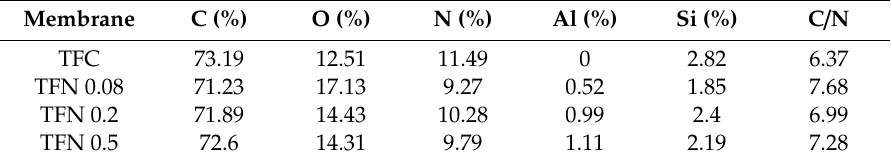
Table 1. XPS results for thin film composite (TFC) and thin film nanocomposite (TFN) membranes.